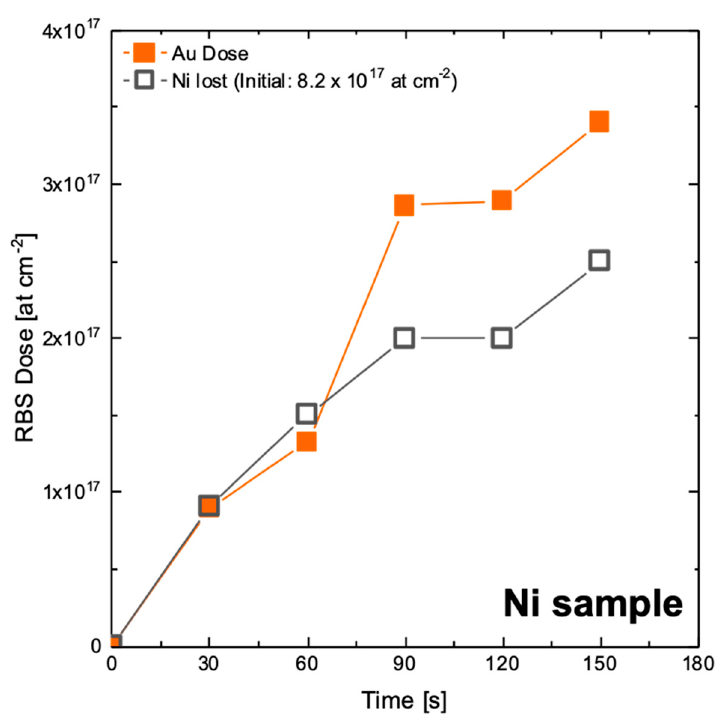
Figure 6. Au dose (orange closed squares) and Ni lost (grey open squares) as a function of immersion